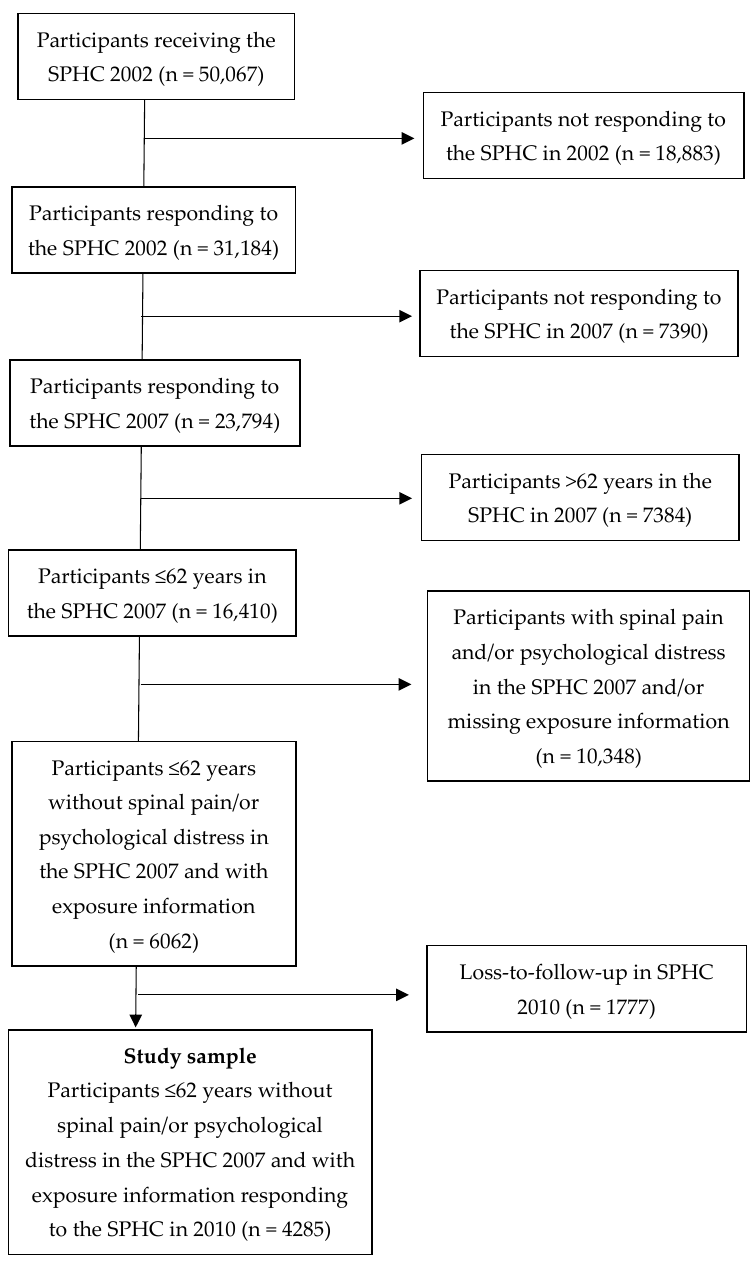
Figure 1. Flowchart of study participant inclusion and follow-up.